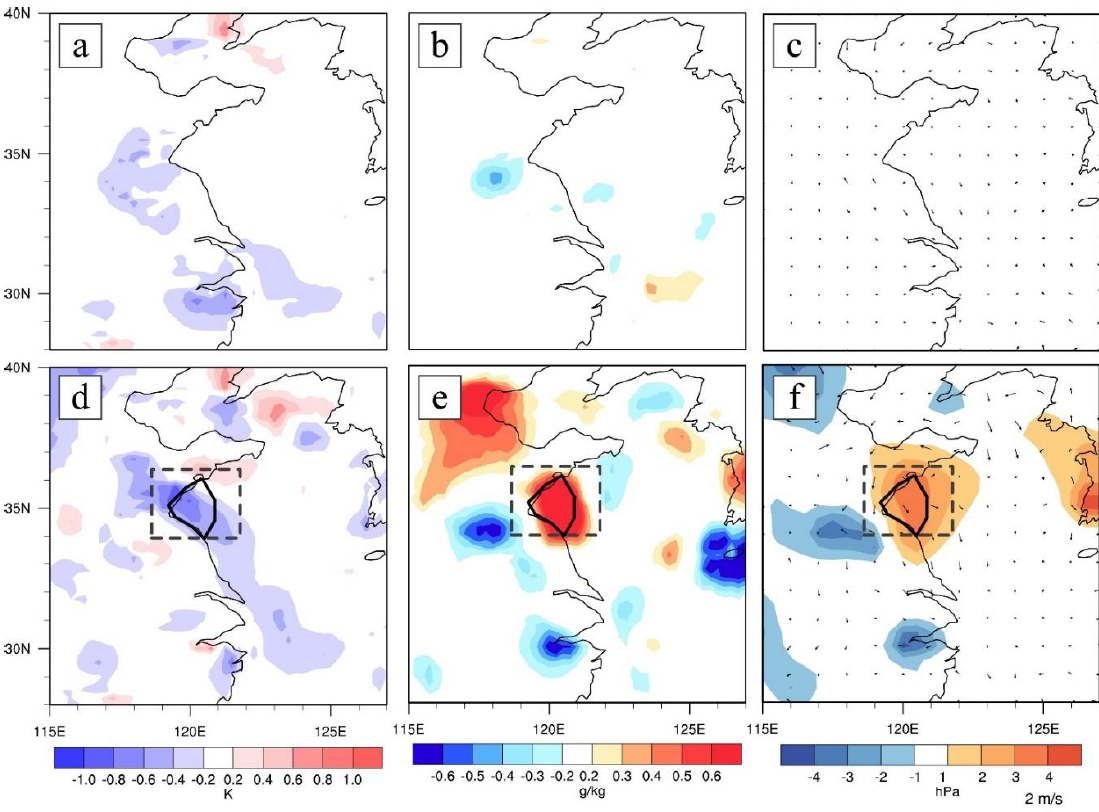
Figure 10. As in Figure 9, but for differences between Exp-B2 and Exp-B1 ( a – c ), Exp-B3 and Exp-B1 ( d – f ), and the forecasted sea fog at 0100 UTC 02 April 2014.